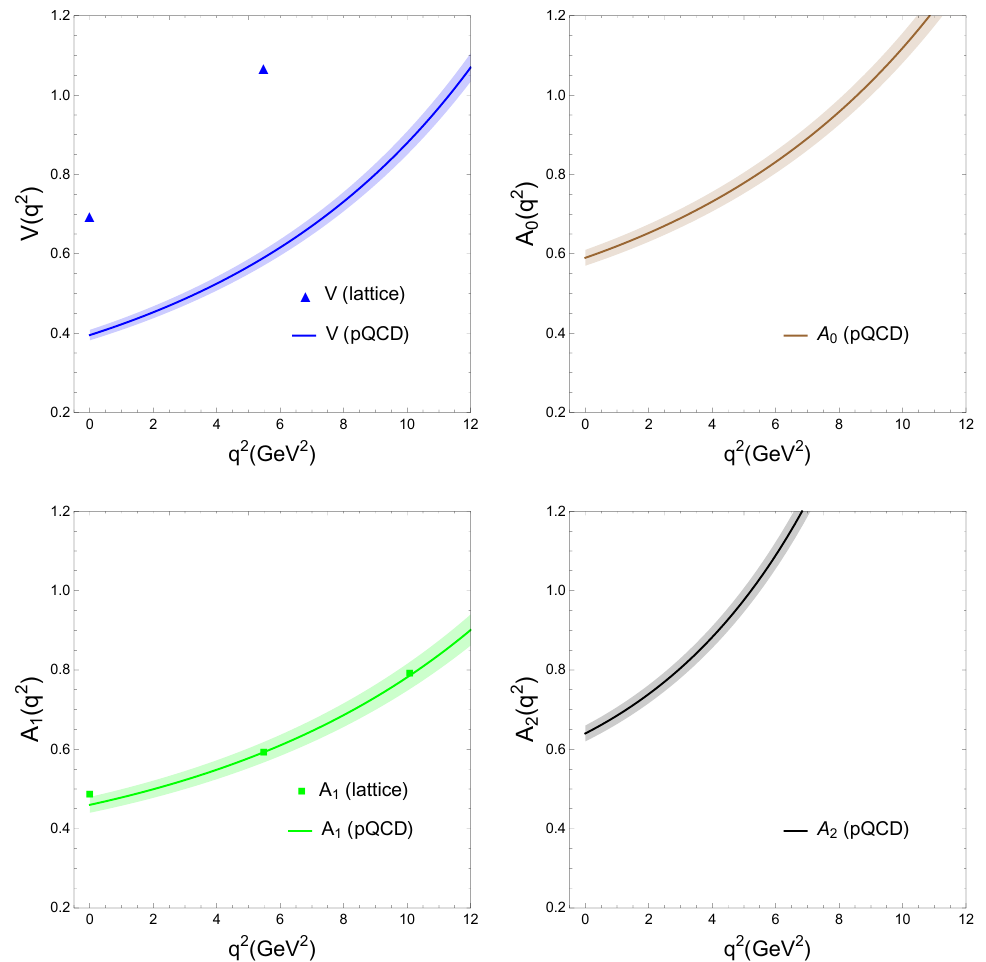
Figure 8 . Form factors V ( q 2 ) B c ! J= , A 0 ( q 2 ) B c ! J= , A 1 ( q 2 ) B c ! J= and A 2 ( q 2 ) B c ! J= from pQCD and